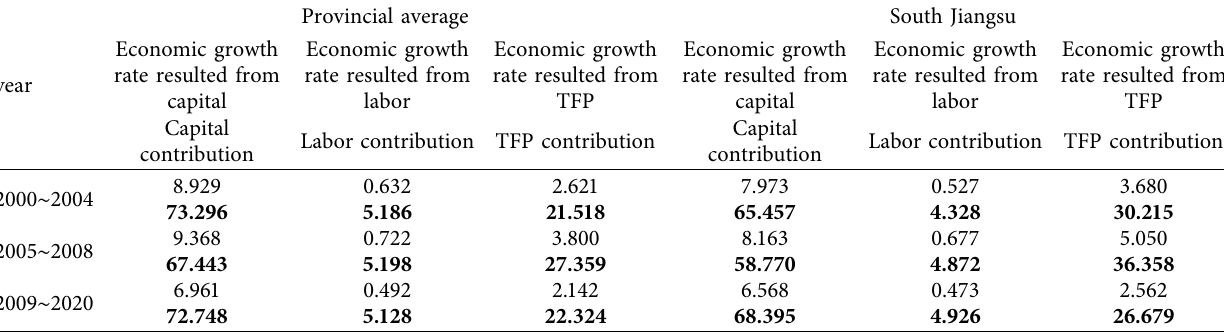
Table 4: The formation features of urban economic development driving force in Jiangsu province and South Jiangsu from 2000 to 2020.